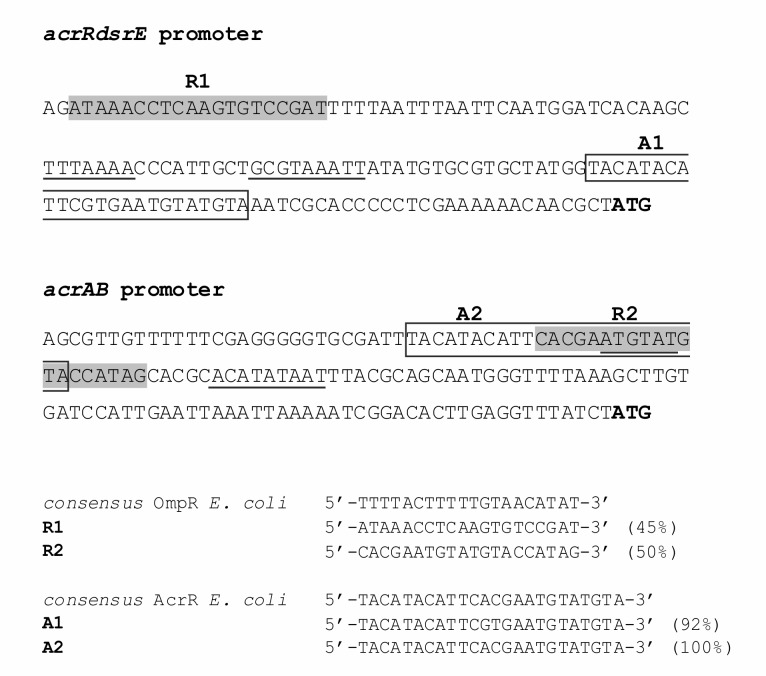
Intergenic sequences upstream of the Y. enterocolitica acrR and acrAB operons.The initiation codons (ATG) are in bold, and putative -35 and -10 promoter elements are underlined. The putative OmpR binding sites identified by in silico analysis (R1, R2) are shaded gray. Potential binding sites for AcrR (A1, A2) are boxed. Potential binding site elements aligned with the E. coli consensus sequences, with the percentage identities presented in parentheses.